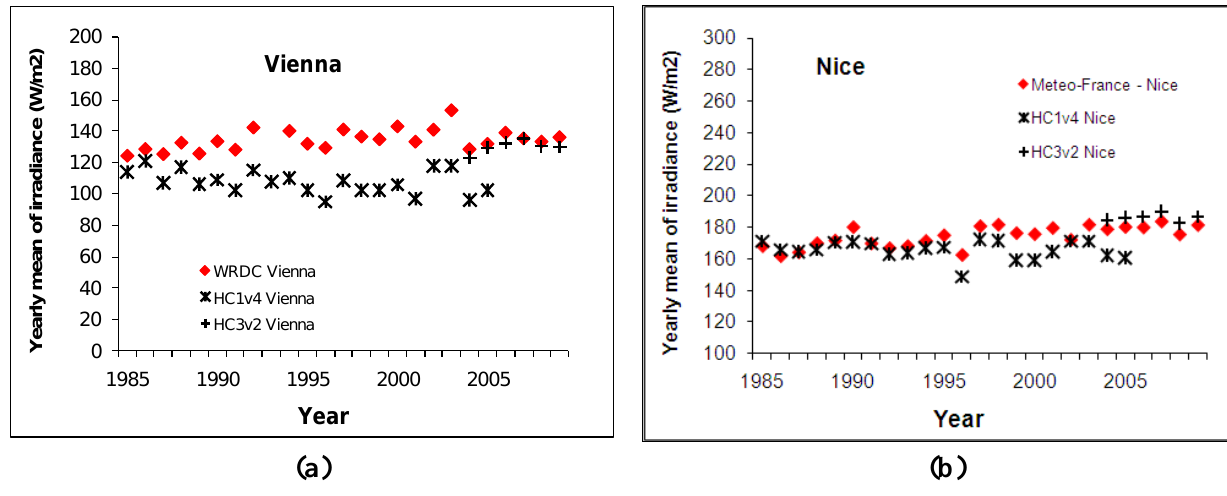
Figure 5. Yearly means of SSI from 1985 to 2009: (a) Vienna; (b)